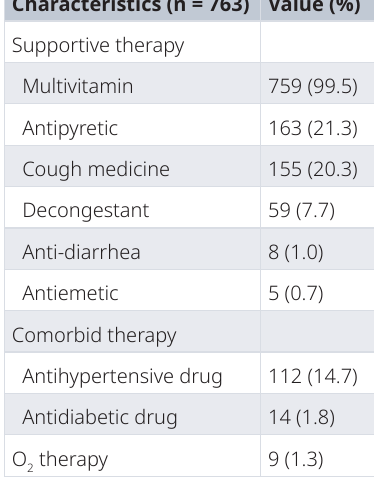
Table 3. Therapy of patients at COVID-19 Emergency Field Hospital of Bangkalan.